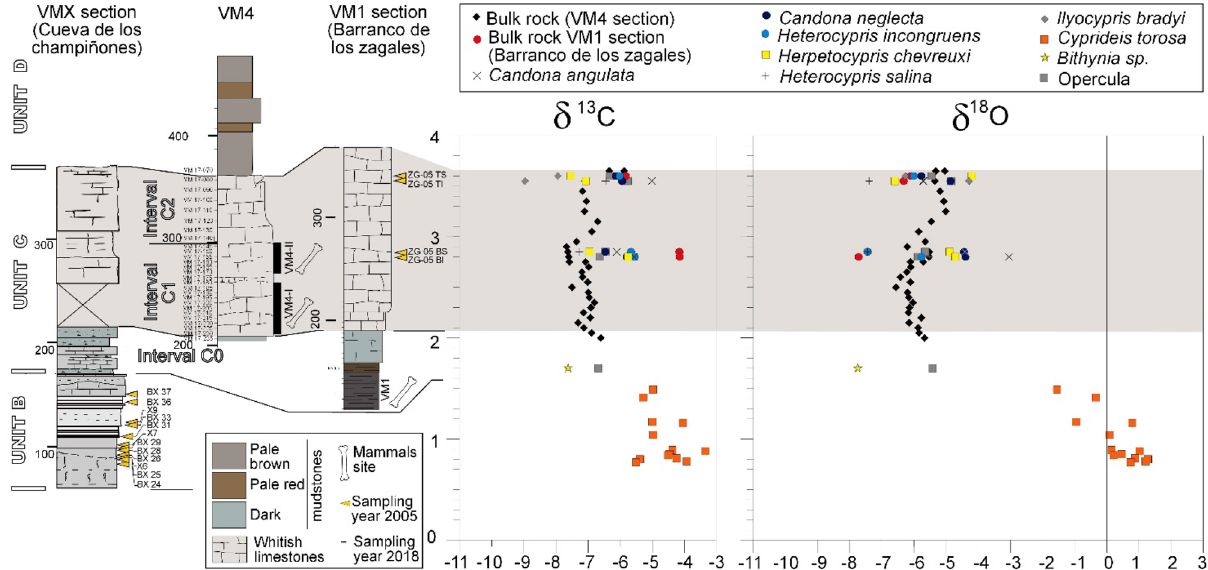
Figure 7. Isotopic stratigraphy of intervals B and C, containing bulk data from sections VM4 and VM1 and invertebrate data from VM1 and VMX. No invertebrate fauna was found from section VM4. See values in STab. 2 and STab.